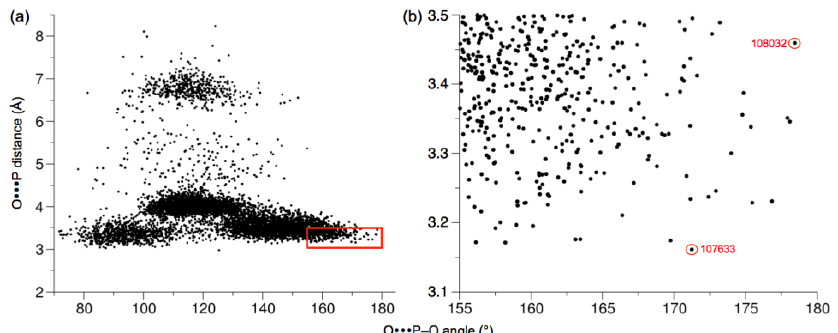
Figure 13. Combination of O···P distances and O···P – O angles in the L2-K1 site during the